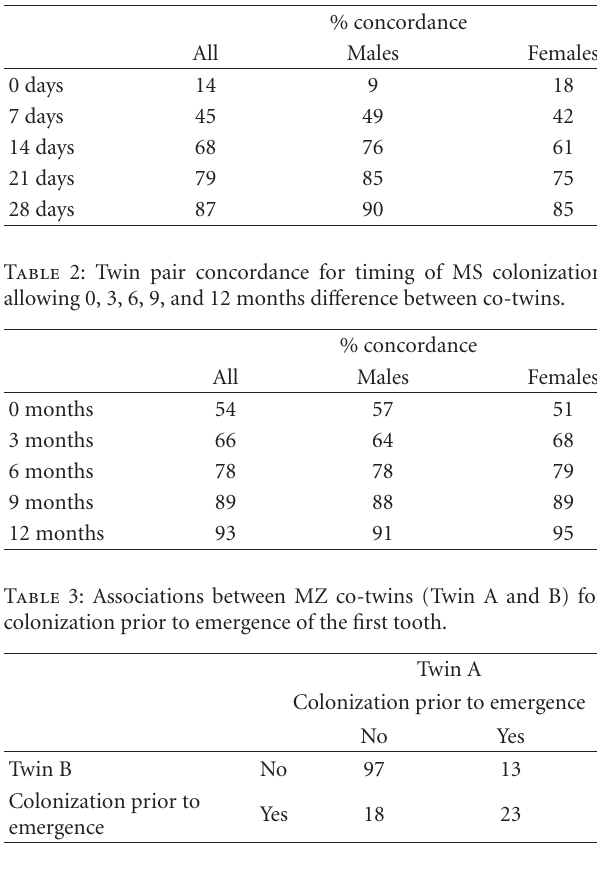
Table 1: Twin pair concordance for timing of emergence of the first tooth allowing 0, 7, 14, 21, and 28 days di ff erence between co-twins.